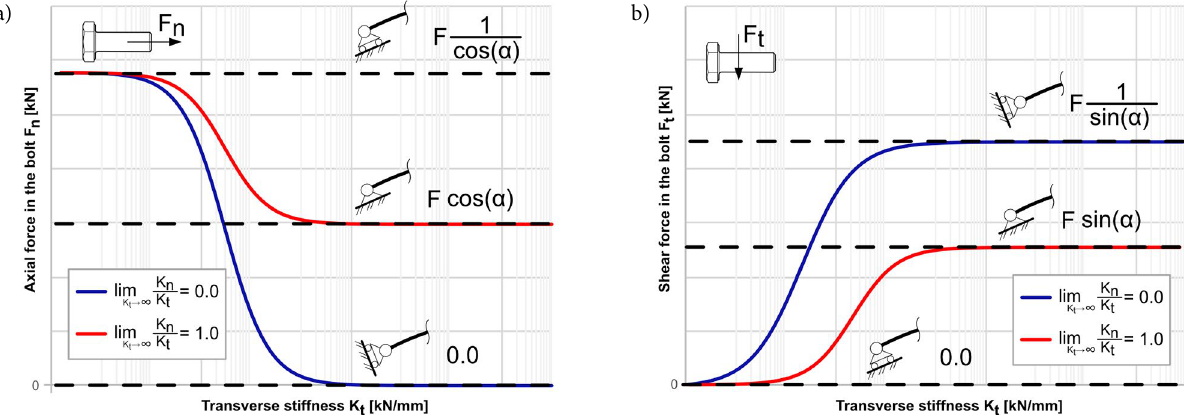
Figure 3. Effect of transverse stiffness on the: a – axial force in the bolt; b – shear force in the